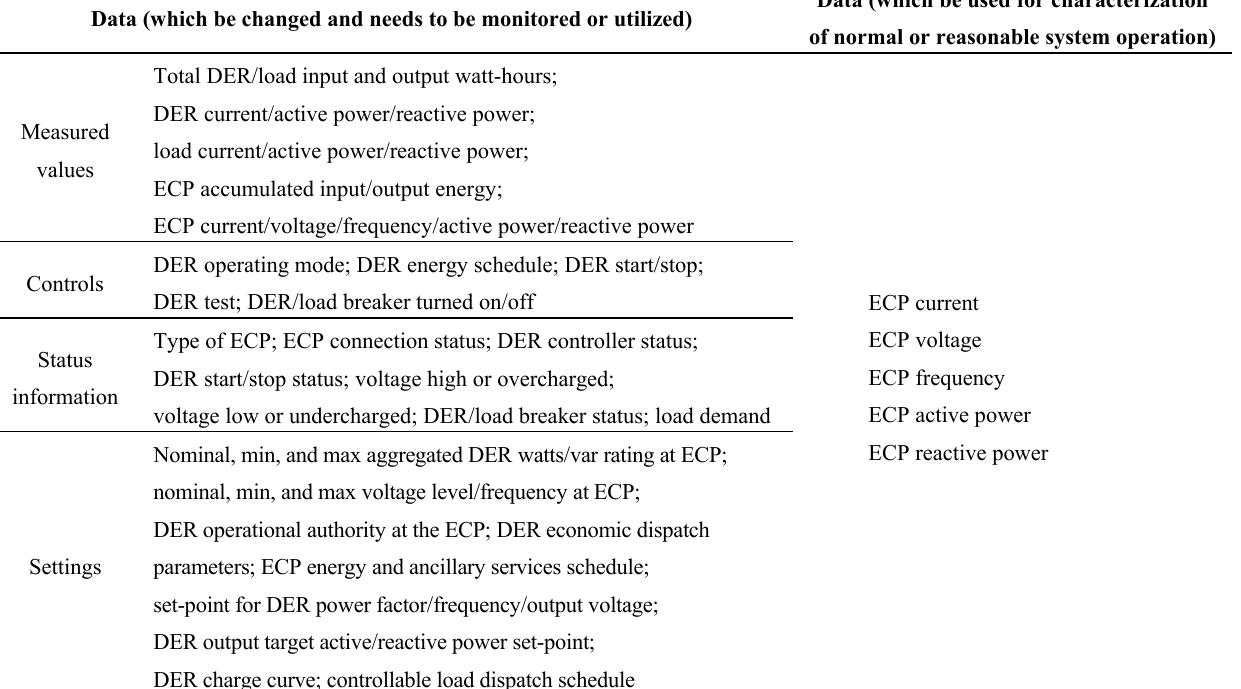
Table 2. Types of data for real time